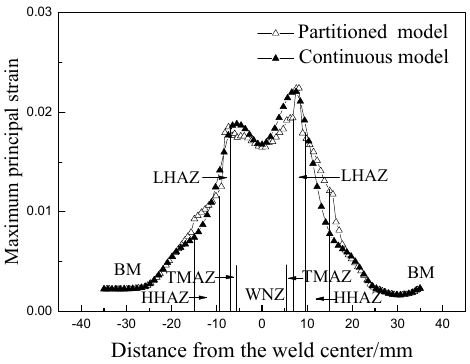
Figure 14. Maximum principal strain distributions of upper surface in the joint model.